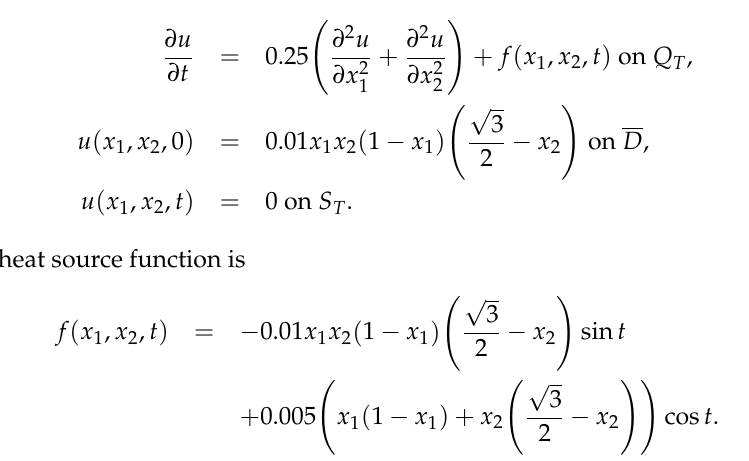
Figure 5. The grid function of absolute errors when t = 0.8 obtained by the method H 4 th the Example